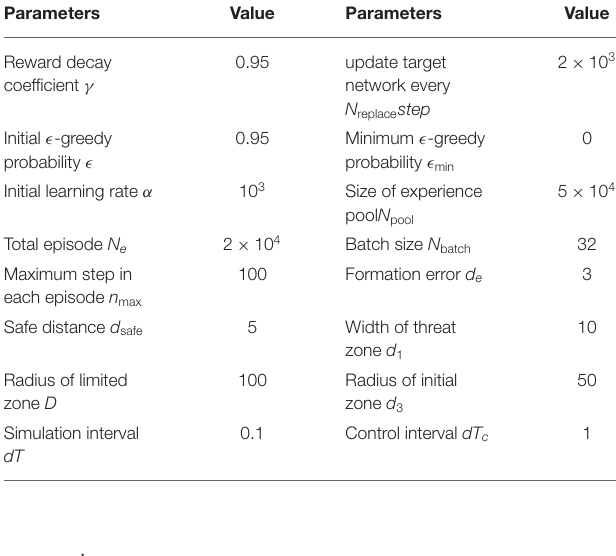
TABLE 1 | Parameter of deep Q network (DQN) and